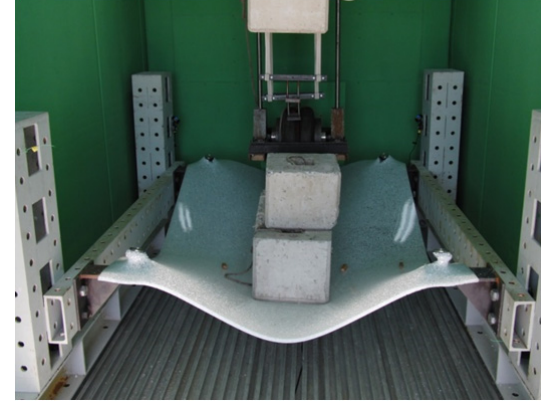
Fig. 12 0.89mm Ionomer laminate collapsed at 200Kg at +50°C Fig. 13 1.52mm Ionomer laminate collapsed at 300Kg at +50°C